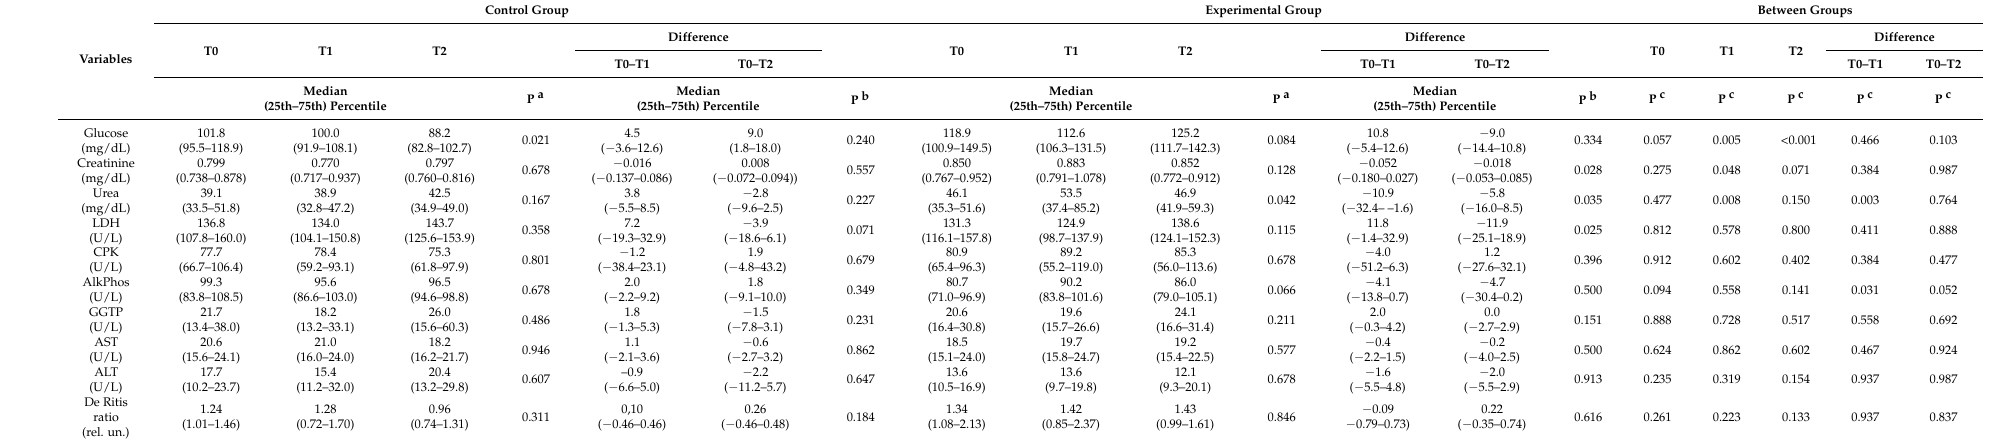
Table 5. Changes in patient serum biochemical parameters during the trial, and comparison between